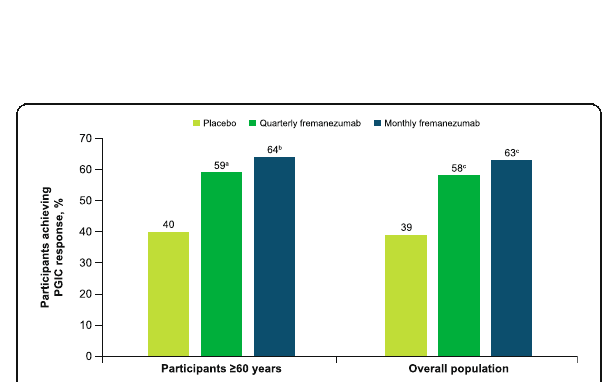
Fig. 9 Proportion of PGIC responders in participants aged ≥ 60 years and the overall population. PGIC, patient global impression of change. Data shown are the proportion of PGIC responders (defined as individuals who reported a rating of 5 – 7 [moderately better, better, or a great deal better] on the PGIC) at Week 12. a P < 0.01 vs placebo. b P < 0.005 vs placebo. c P < 0.0001 vs